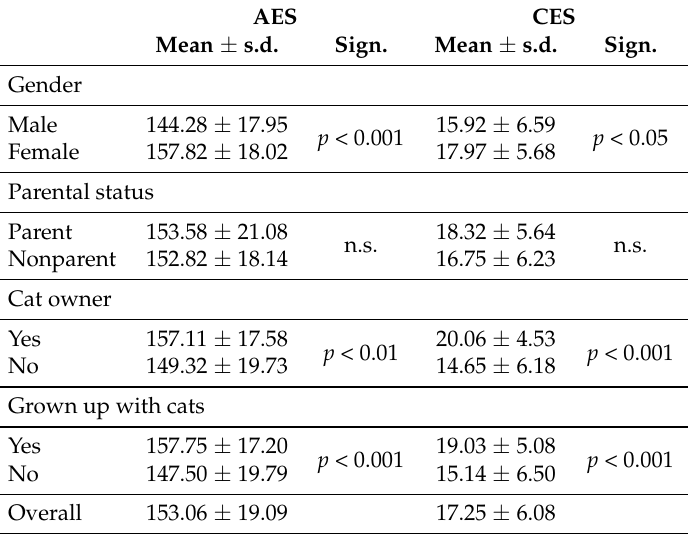
Table 3. Mean ( ± SD) of AES and CES of the participants, depending on their gender or experience with cats, and relative significance levels.